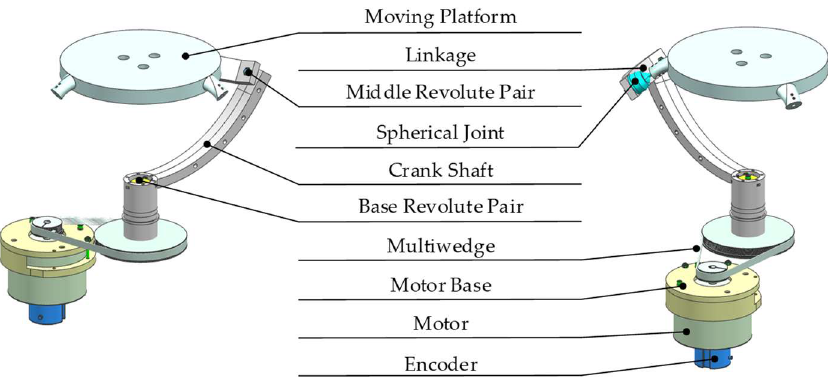
Figure 3. Branch-chain structure of RRS.